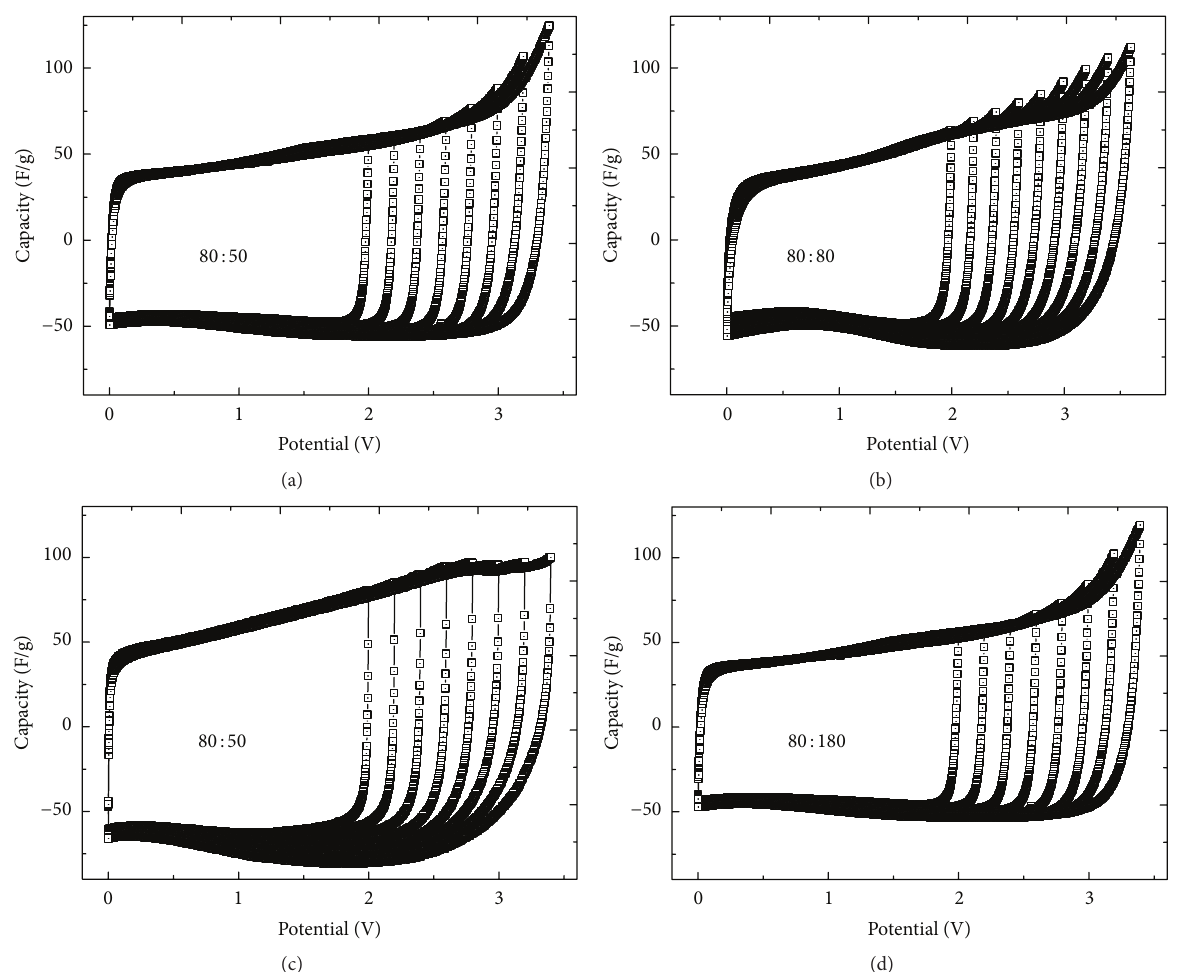
Figure 3: Cyclic voltammetry cures. (a) 𝑟 = 80 :50. (b) 𝑟 = 80 : 80. (c) 𝑟 = 80 :120. (d) 𝑟 = 80 :